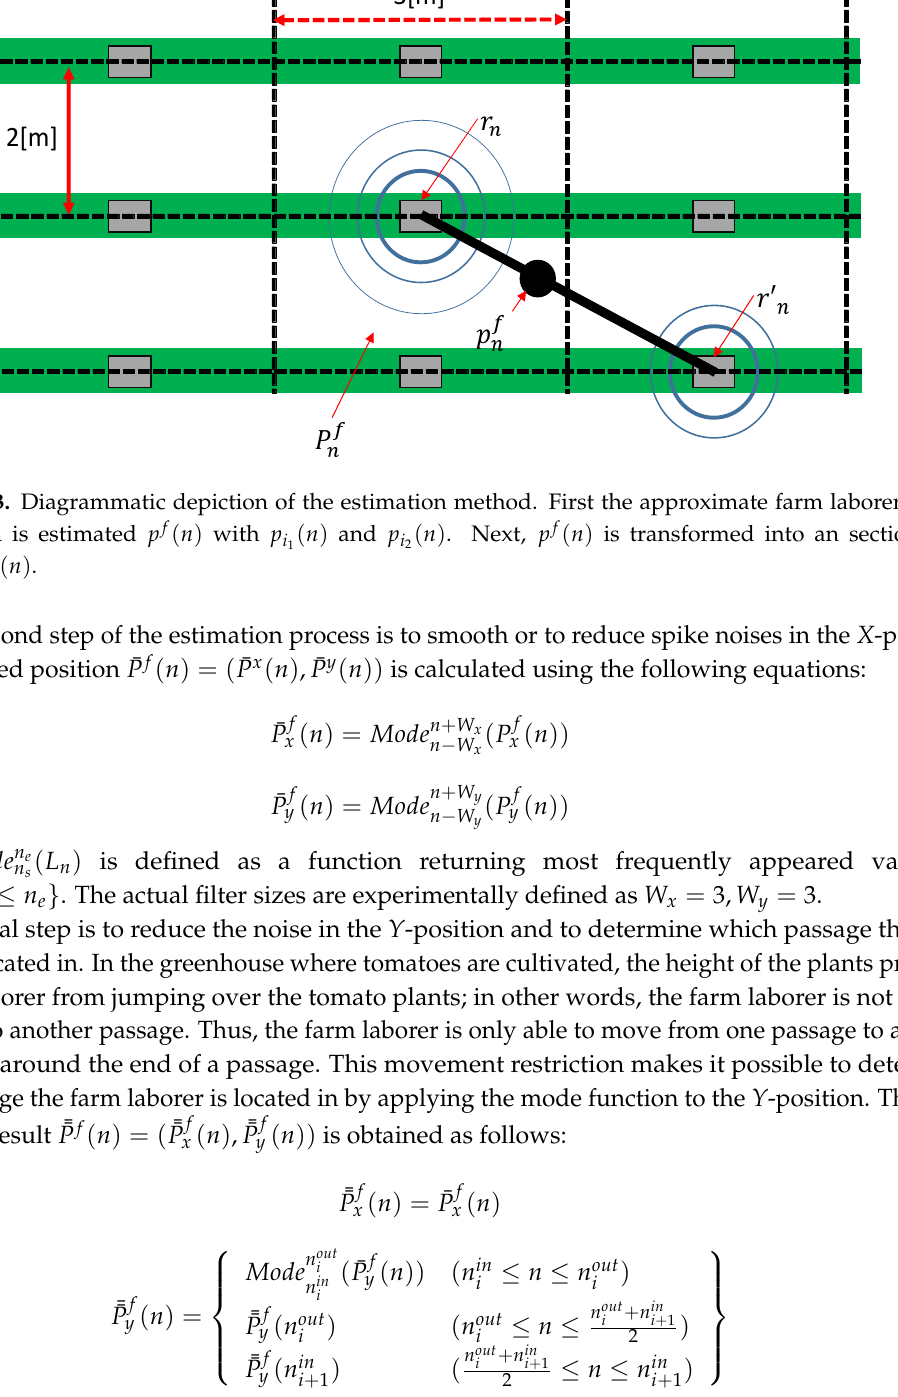
( n ) and p ( n ) . Next, p f ( n ) is transformed into an i 2 1